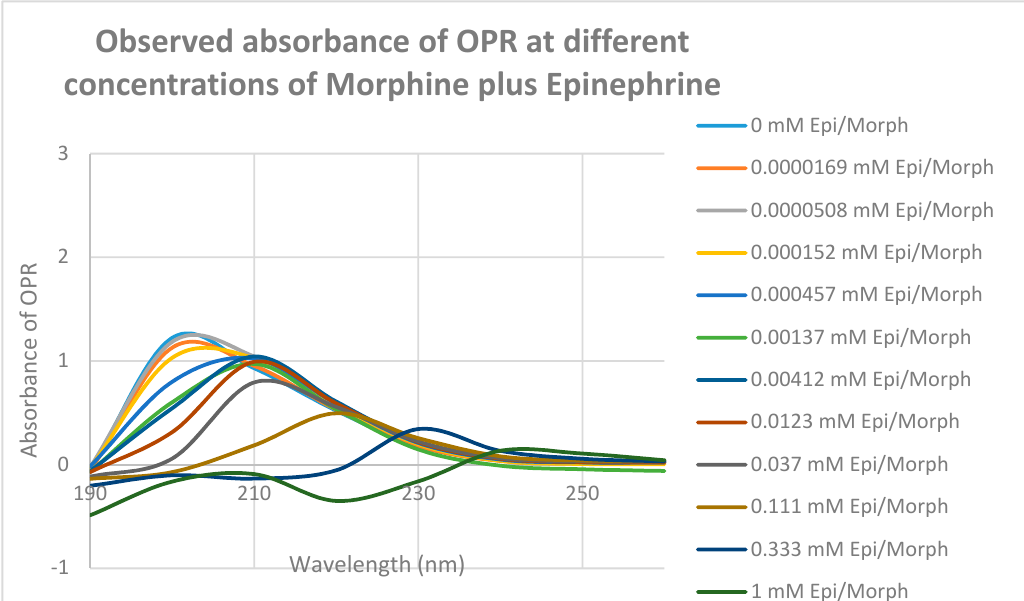
Figure 18. UV spectra of mu opioid receptor (OPR) with serial additions of both morphine and epinephrine (EPI) in tandem. Note the obvious differences from Figures 13 and 17.